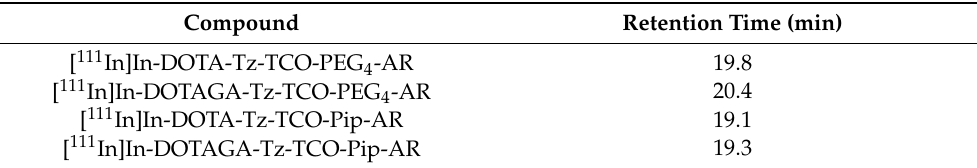
Table 1. Retention times (min) of the [ 111